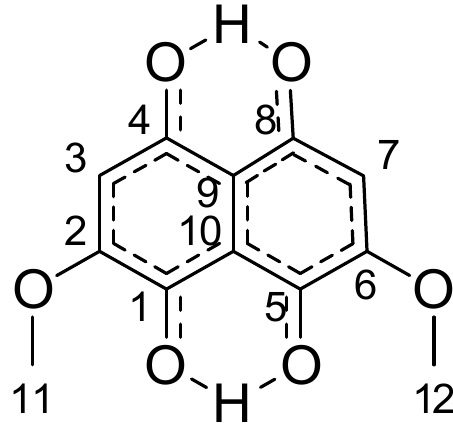
Figure 6. Tautomer structure of 3,6 di-methoxy (di-hydroxyl-napthoquinone).